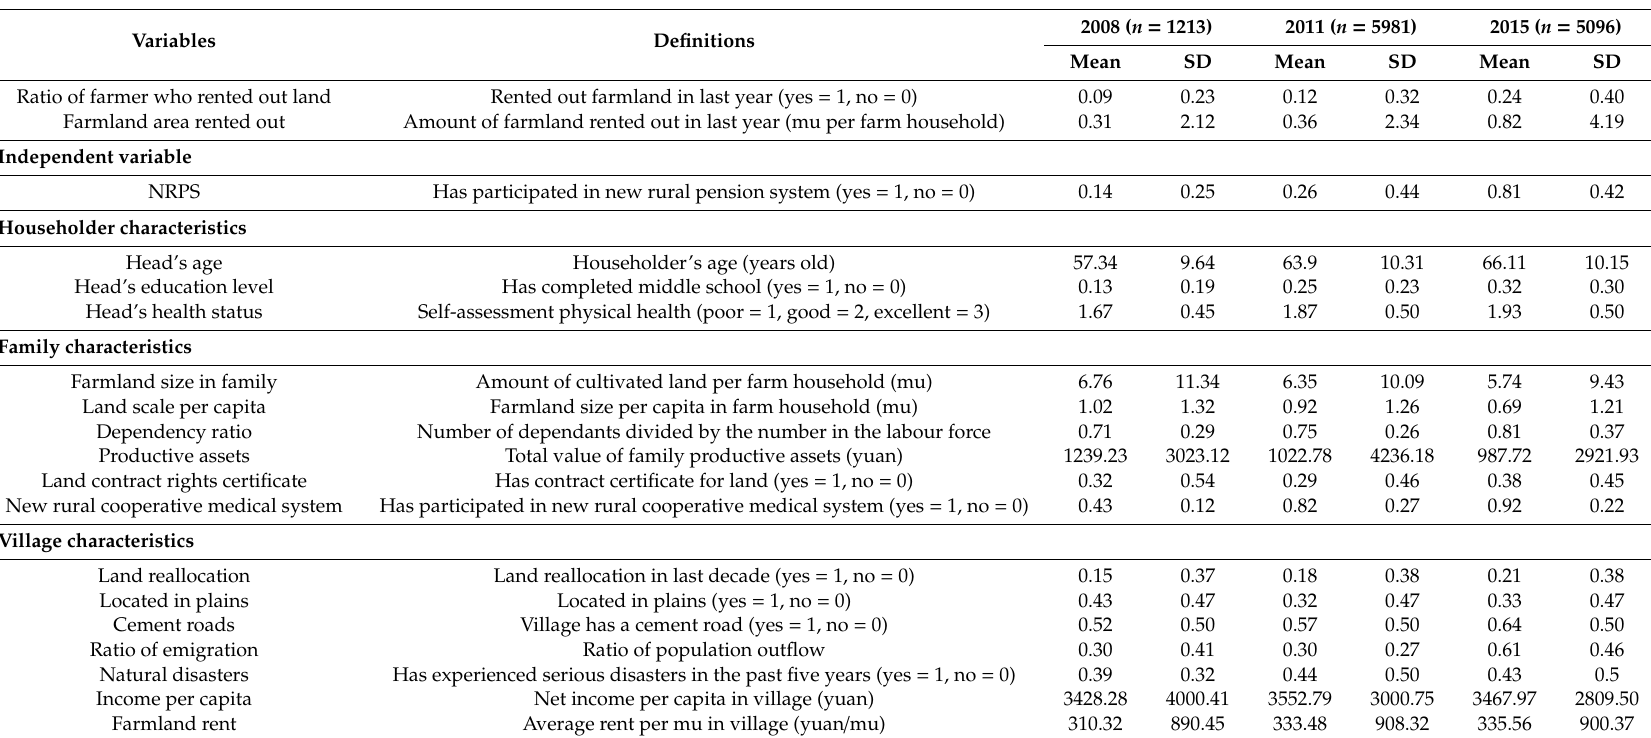
Table 4. Definitions and statistical descriptions of